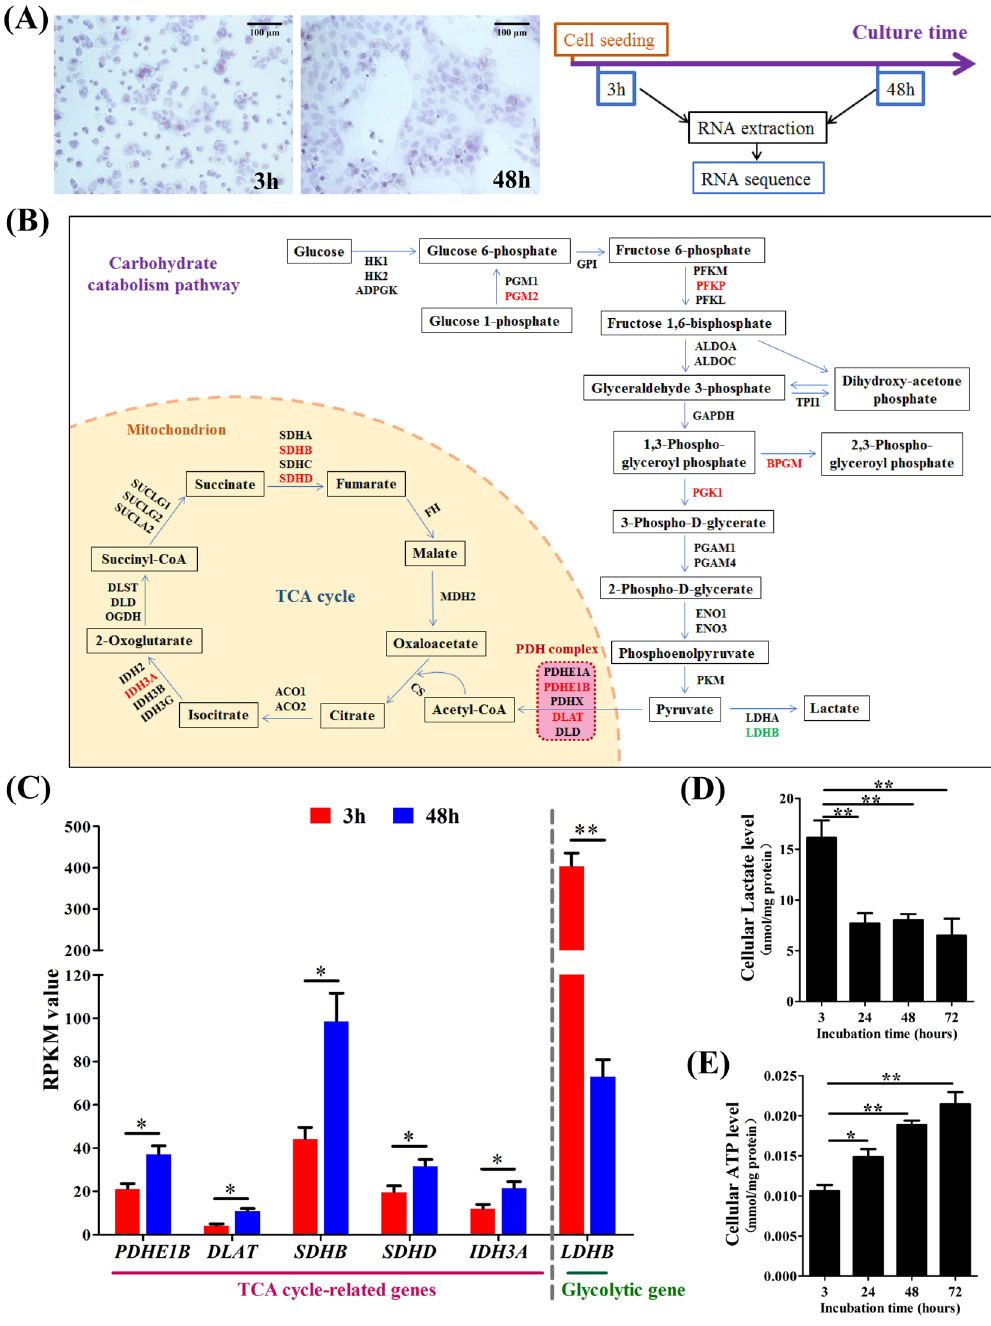
Figure 1. Alteration of carbohydrate catabolic pathway during syncytialization of human placental trophoblasts. ( A ) Hematoxylin staining showing morphological changes of human placental trophoblasts during syncytialization. The trophoblasts were collected before (3 h) and after (48 h) syncytialization for transcriptomic analyses. ( B ) A diagram depicting the changes of genes encoding enzymes involved in glycolysis and tricarboxylic acid (TCA) cycle during syncytialization with transcriptomic analyses. Red: up-regulated genes, Green: down-regulated gene. ( C ) Changes in the values of Reads per Kilobases per Millionreads (RPKM) of the differentially expressed genes during syncytialization. n = 3. ( D ) and ( E ) Changes in the cellular lactate (n = 5, D ) and ATP levels (n = 3, E ) during syncytialization. * P < 0.05; ** P < 0.01 against 3